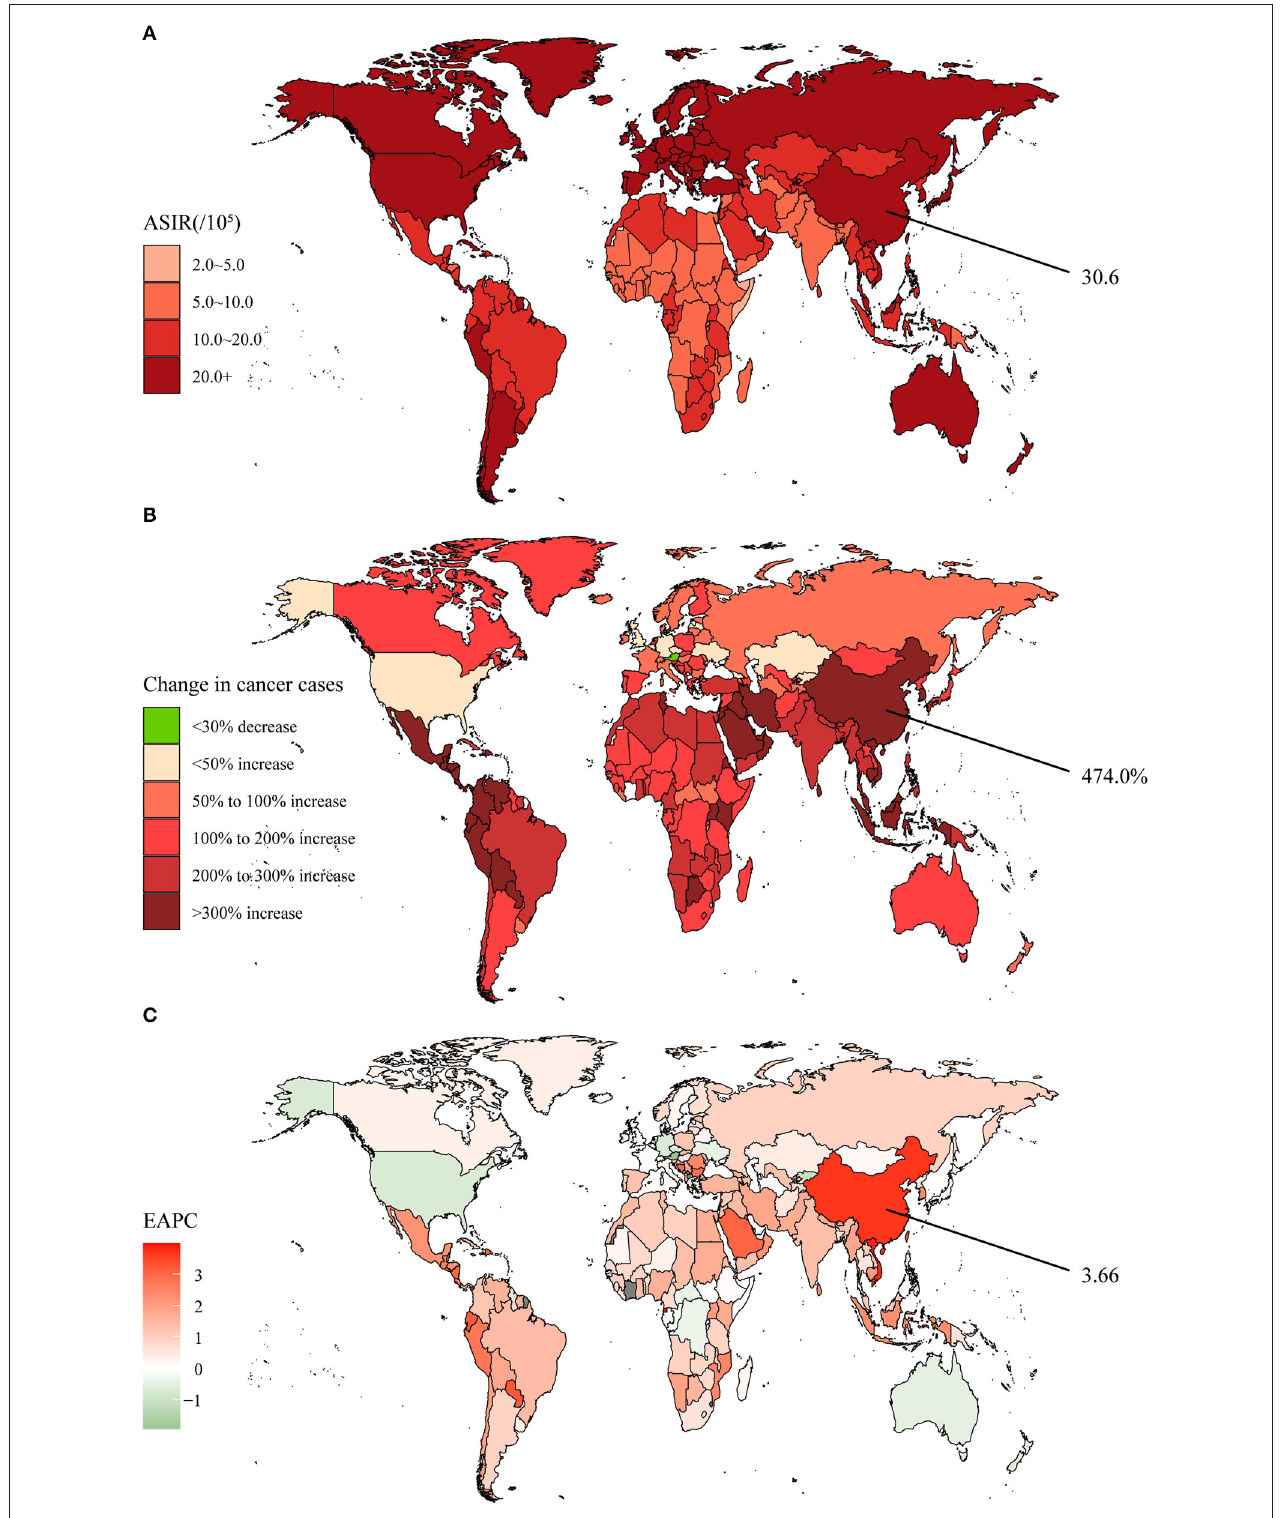
FIGURE 5 | The global disease burden of colon and rectum cancer in 204 countries and territories. (A) The ASIR in 2019; (B) The relative change in incident cases between 1990 and 2019; (C) The EAPC of ASIR from 1990 to 2019. Outcomes of China were specifically annotated. ASIR, age-standardized incidence rate; EAPC, estimated annual percentage